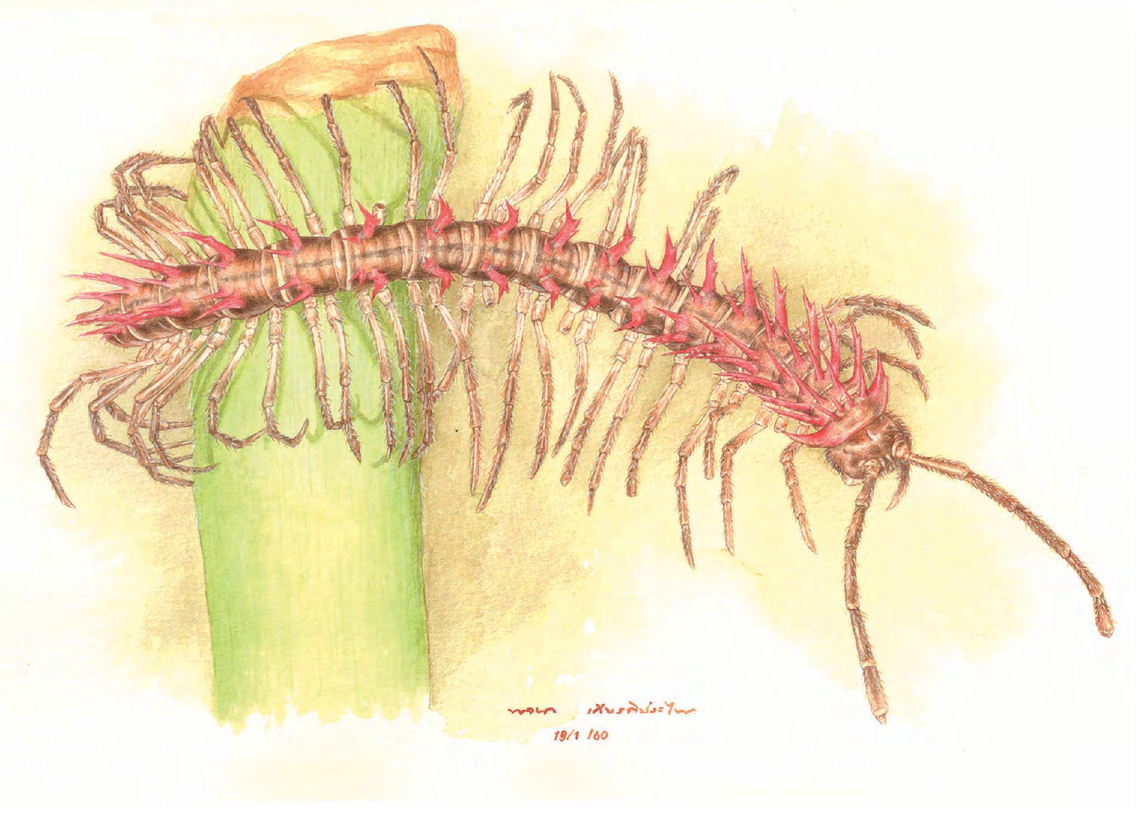
Fig. 1. Nagaxytes gracilis Srisonchai, Enghoff & Panha gen. et sp. nov., ♂, paratype (CUMZ- pxDGT00095). Watercolour by R. Srisonchai and P.